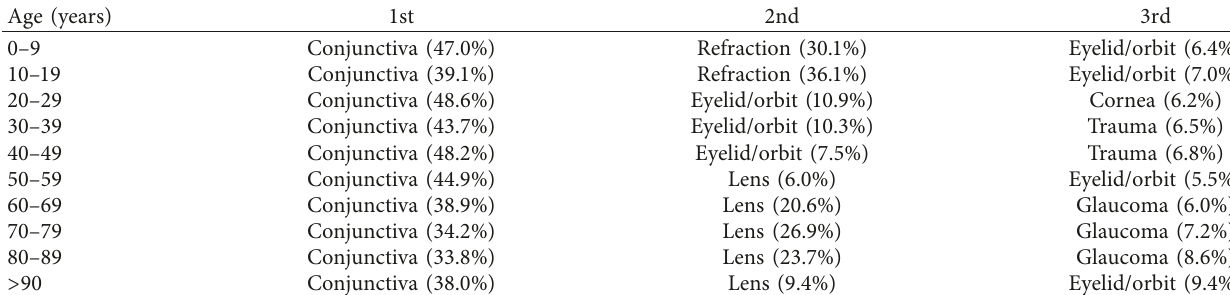
Table 4: Three most frequent disease categories in each decade of life.